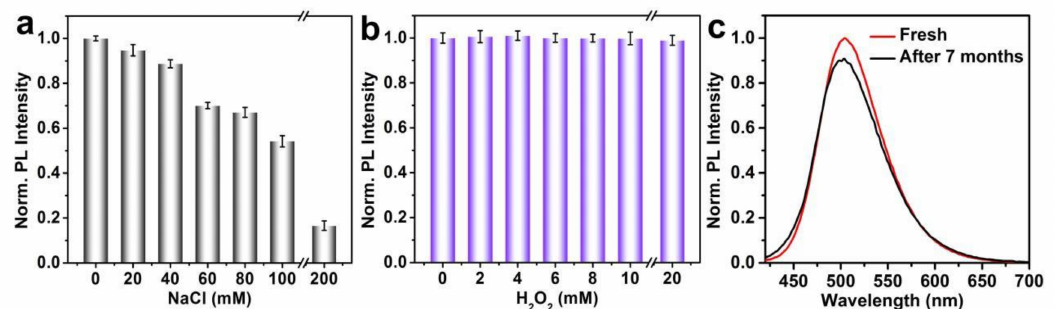
Figure 7. ( a , b ) The normalized PL intensity histograms of aqueous Cu NCs@AA incubated with various concentrations of NaCl and H 2 O 2 , the incubated volume ratio of Cu NCs:NaCl is 1:2, and that of Cu NCs:H 2 O 2 is 4:1. ( c ) Time stability of Cu NCs@AA.